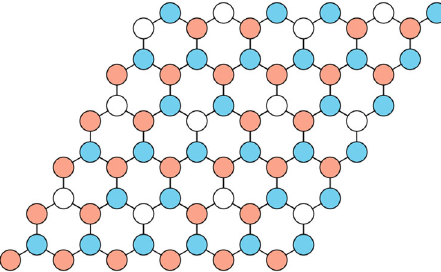
Fig. 5 One example of a nematic charge-ordered state at ν = 2 − 1/3 fi lling. The con fi guration was obtained by subtracting the ν = 1/3 state (i.e., that shown in Fig. 3b, d) from a uniform ν = 2 state proposed in refs. 15,16 . The fi lled red and blue circles represent fi lled Wannier states on the AB and BA sublattices, respectively, while empty circles represent holes relative to the uniform ν = 2 state. Since the holes are placed in the same pattern as Fig. 3b, d, the resulting ν = 2 − 1/3 state is also nematic. Similarly, this state is also ferromagnetic due to the exchange interactions between the